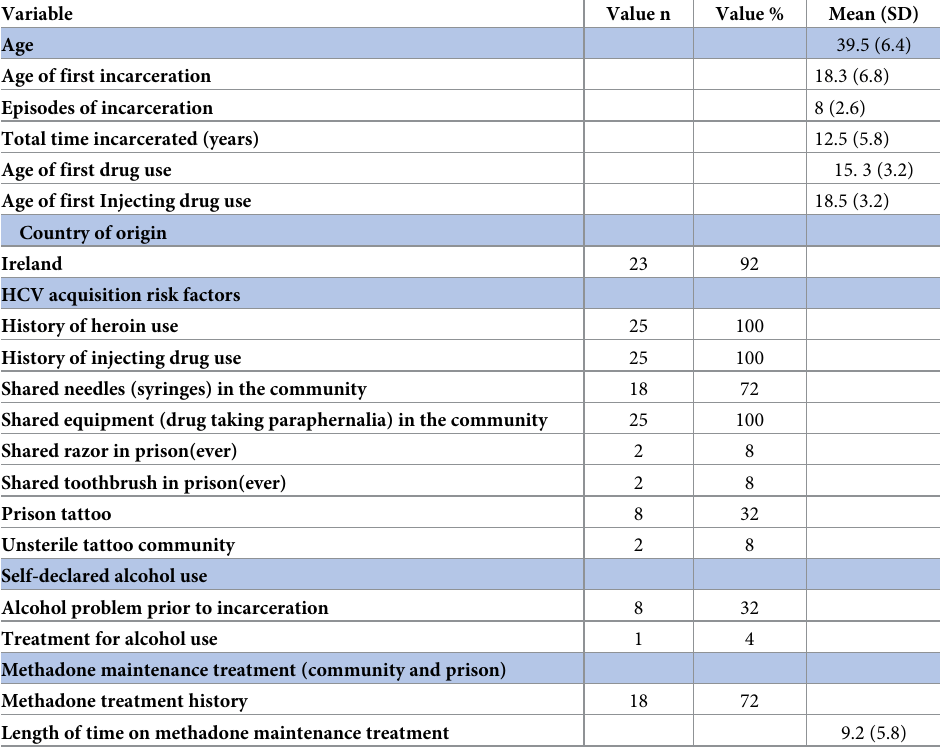
Table 2. Demographics of study participants in Mountjoy Prison, Ireland (September 2018).